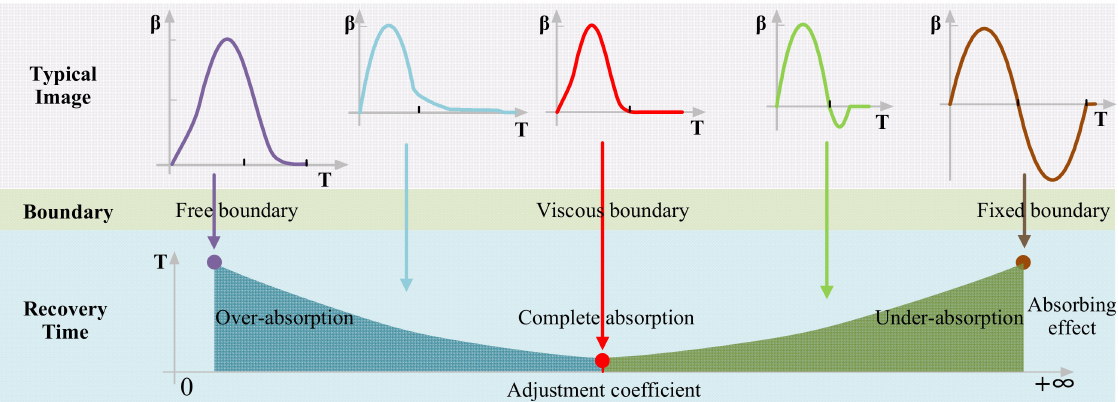
Figure 8. Variation of single adjustment coefficient and absorbing effect of the viscous